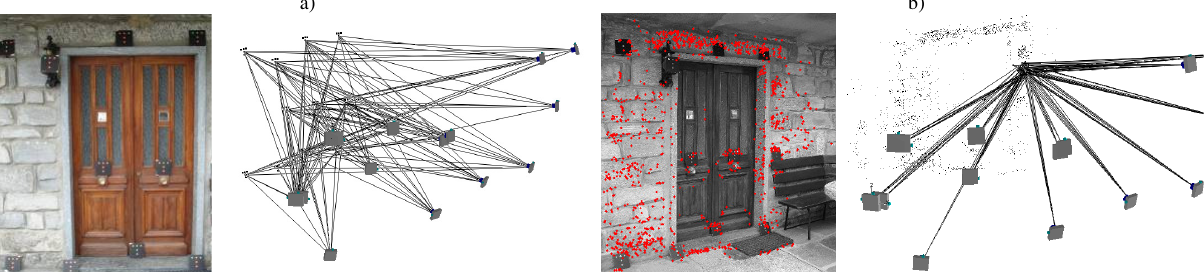
Figure 1. A target-based calibration procedure (a) and the targetless approach